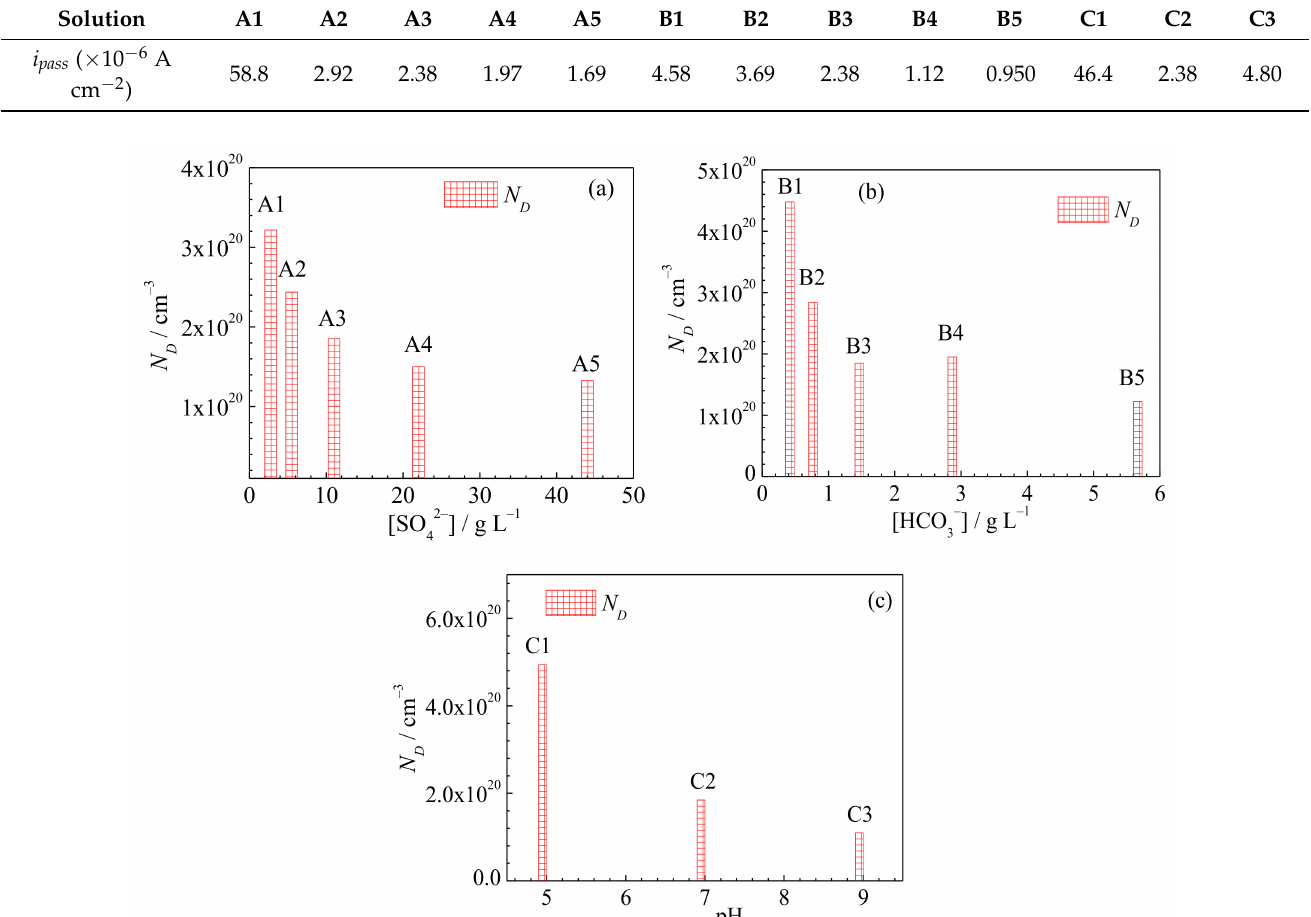
Table 4. The passive current density of 201 low-nickel stainless steel in different solutions.